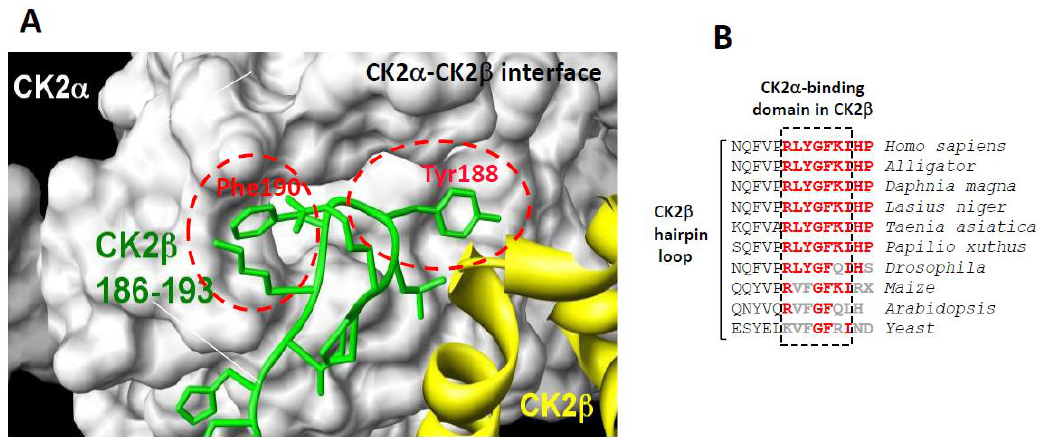
Figure 1. ( A ) surface representation of the binding pocket of CK2α interacting with a short C-terminal hairpin loop of CK2β adapted from [1]. Crystal structure of the CK2 holoenzyme shows that a C-terminal fragment of the CK2β1chain encompassing residues 186–193 (green) forms a loop inserting into a deep hydrophobic pocket of CK2α [12]. Surface representation of the CK2α cleft in grey highlights its pocket-like characteristics. The phenol and phenyl rings of the two non-polar and aromatic CK2β residues Tyr188 and Phe190, respectively, (red) are in quasi-planar opposite orientation and fit tightly into it; and ( B ) a highly conserved cluster in the C-terminal domain of CK2β in different species.